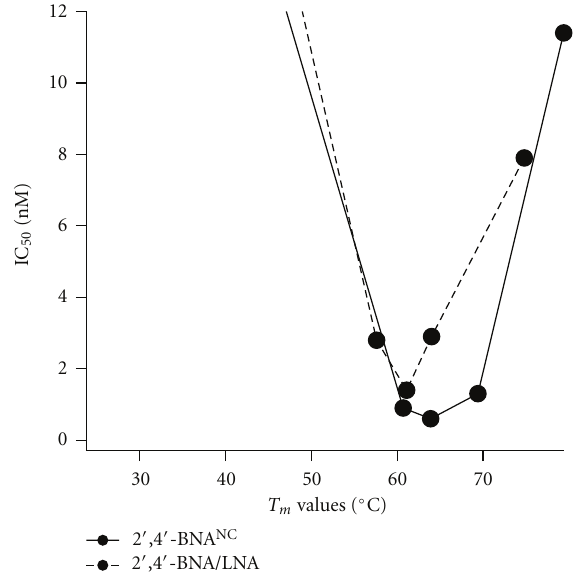
Figure 4: Relationship between target a ffi nity and antisense potency. IC 50 as a function of T m values of 2 (cid:2) ,4 (cid:2) -BNA NC -based AONs (solid line) and 2 (cid:2) ,4 (cid:2) -BNA/LNA-based AONs (dotted